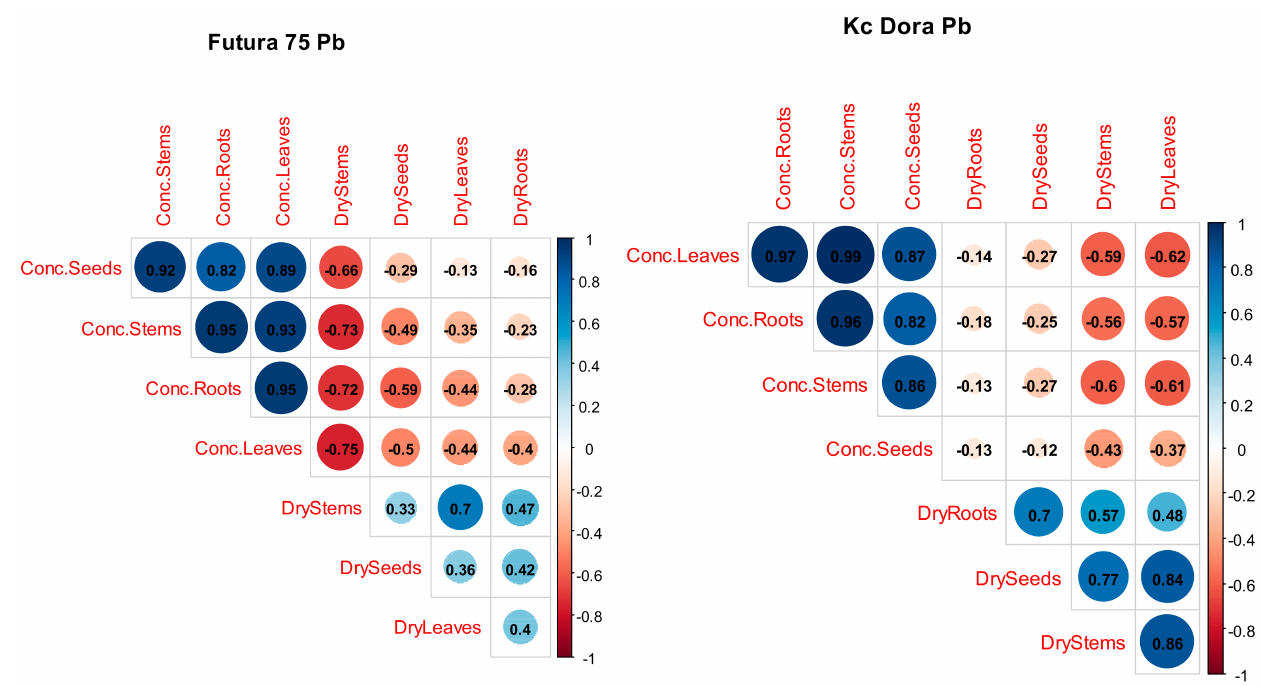
Figure 7. Correlation matrix of Pb of Futura 75 and KC Dora, using as the variable the biomass yield of roots, stems, leaves, and seeds, and the concentration of the heavy metal measured in each part of the plant. The numbers within the circles represent the Pearson correlation